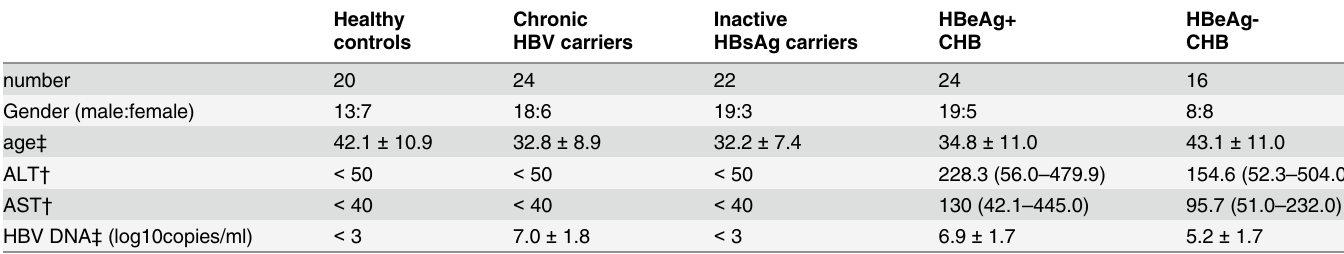
Table 1. Demographic Characteristics and Clinical